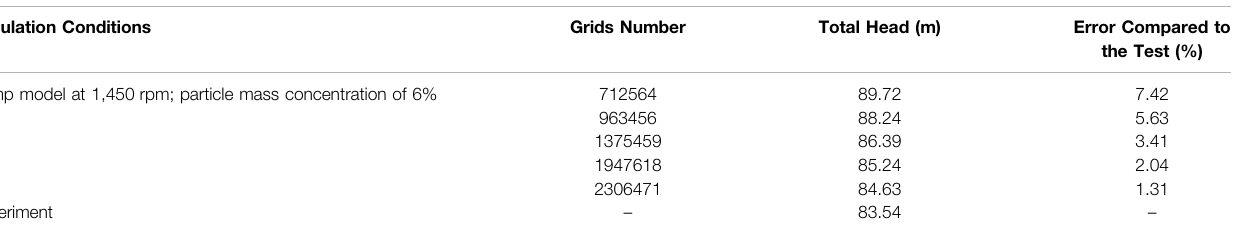
TABLE 4 | Grid-independence simulation test.